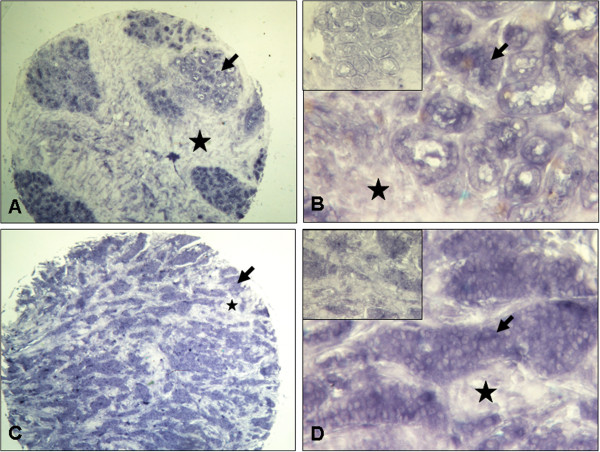
SERBP1 mRNA is expressed in breast epithelial cells but not in stromal cells as shown by non-radioisotopic in situ hybridisation SERBP1 expression was investigated by non-radioisotopic RNA in situ hybridisation in a subset of normal (n = 10) and cancerous (n = 10) breast tissue samples derived from the initial TMA set. (A, B) Normal breast tissue with moderate SERBP1 mRNA expression in the epithelial cells (arrow) and no stromal (asterisk) staining using antisense SERBP1 RNA. (B) Insert shows no staining by SERBP1 sense RNA. (C, D) Invasive breast carcinoma (here: ductal type) also revealed moderate SERBP1 mRNA expression in the epithelial cells (arrow) applying antisense SERBP1 RNA whereas no staining could be seen in stromal cells (asterisk) (D) Insert shows negative staining by SERBP1 sense RNA. Magnifications: A, C: 40x; B, D: 200x.